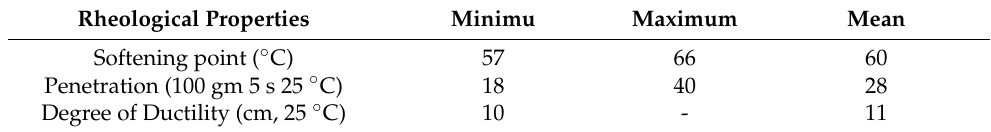
Table 3. Properties of bitumen binder